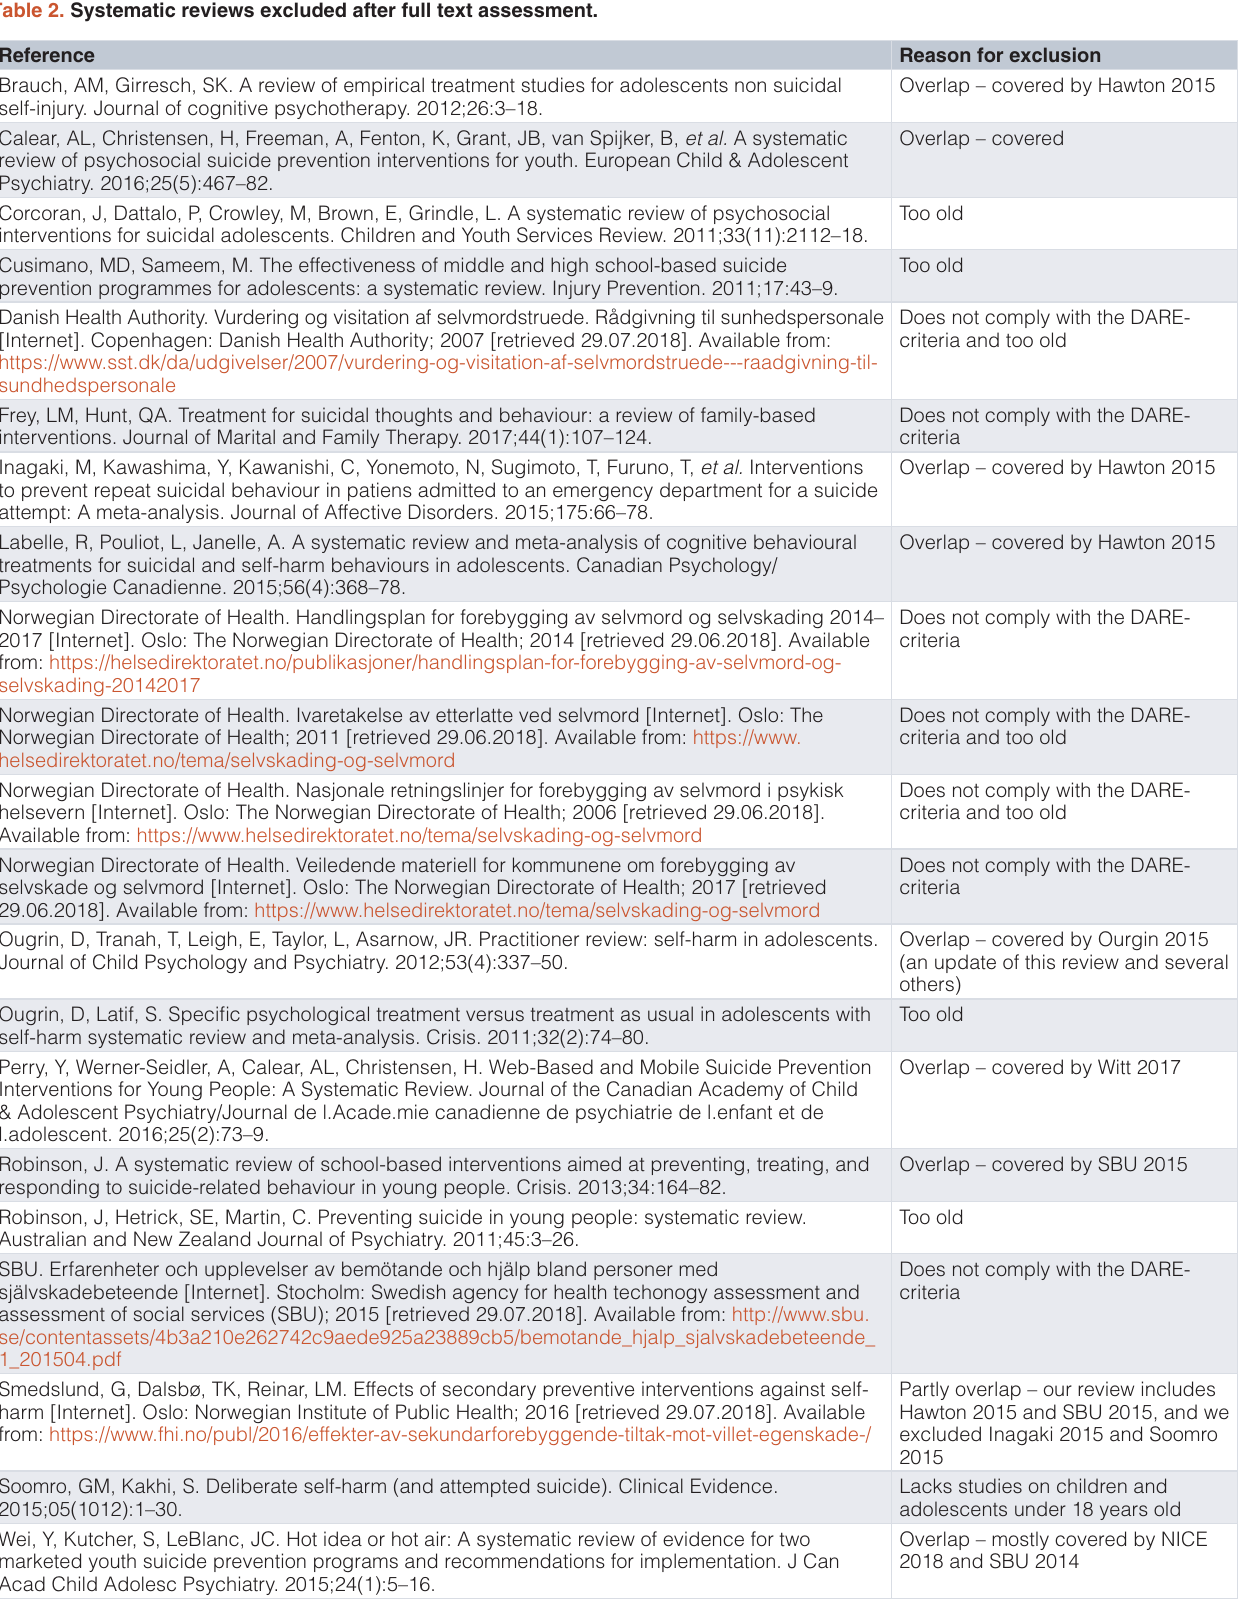
Table 2. Systematic reviews excluded after full text